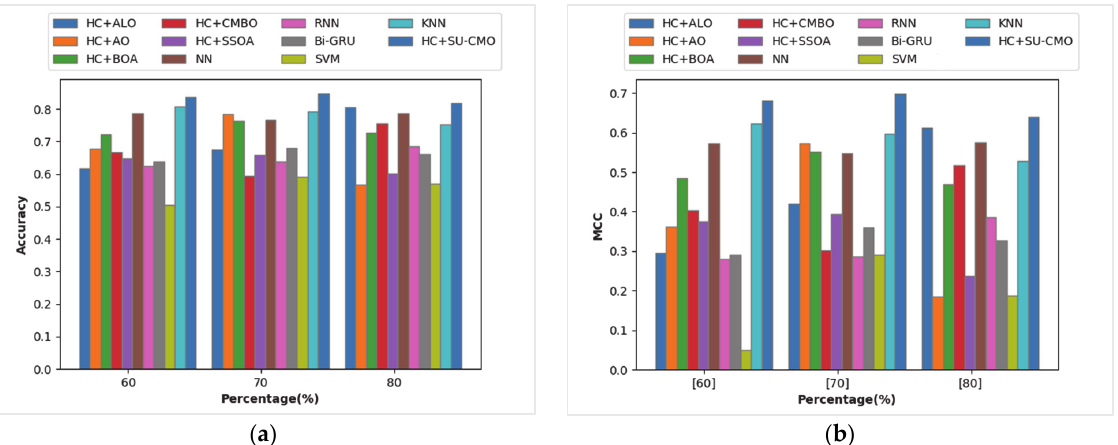
Figure 5. Performance of the adopted model over other existing schemes for dataset 2 ( a ) Accuracy ( b ) MCC.